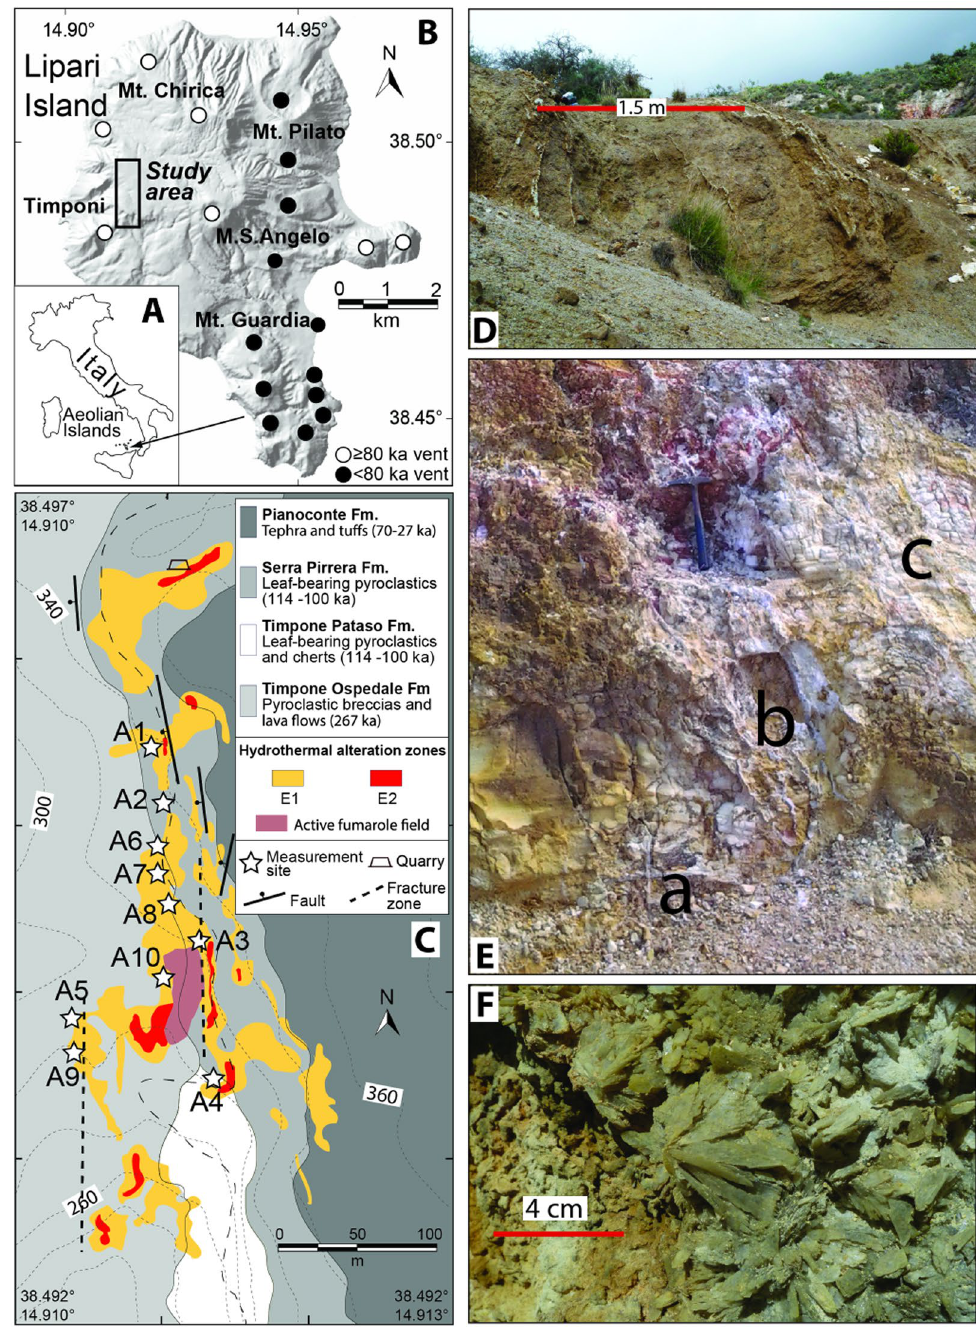
Figure 1. ( A ) Location of Lipari Island. ( B ) Shaded relief of Lipari Island with location of the main eruptive vents. ( C ) Geological map of the alteration zones, fractures and faults, and sites of measurements. Background colors in C indicate the different geological units along with ages 11 as shown in the right insets. The thin dashed black line indicates the trail. ( D ) Outcrop A5 (E1 zone, view from the South) showing a system of ca. N-S striking gypsum and anhydrite filled veins with a sub-parallel arrangement affecting the welded to altered scorias of Timpone Ospedale Formation. ( E ) Outcrop A4 (E2 zone, view from the Southwest) showing cm-sized veins with orthogonal (a), quasi-anastomosed (b), and sub-parallel (c) arrangement. ( F ) Gypsum crystals filling a now inactive hydrothermal vent (measurement station A4 in C). The maps A, B, and C of this figure were generated with Adobe Illustrator CC 2015.0.0 by Adobe Systems (www.adobe.com, institution